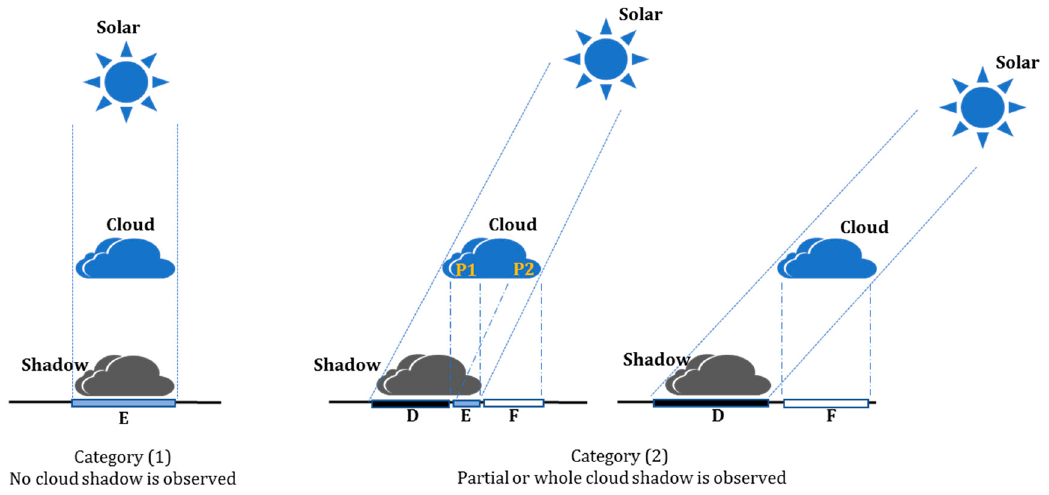
Figure 2. Three cases for correcting solar-cloud-sensor geometry effect on derived SWDR from space. ( D : Shadow shown on the image; E : shadow covered by cloud, and F : bright surface covered by cloud). According to the above analysis, all three cases of D , E and F should be properly